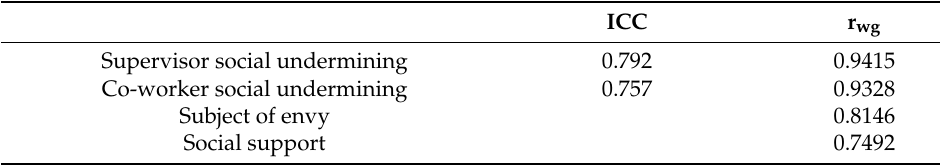
Table 3. ICC and rwg results of some indicators.